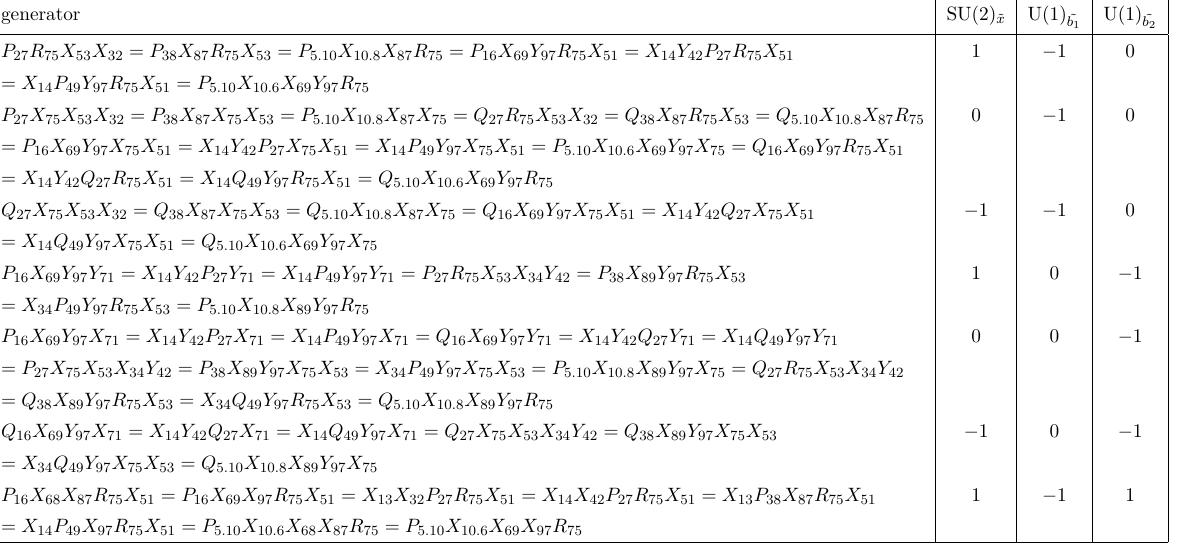
Table 65 . The generators in terms of bifundamental chiral fields for Model 16 (Part 1)